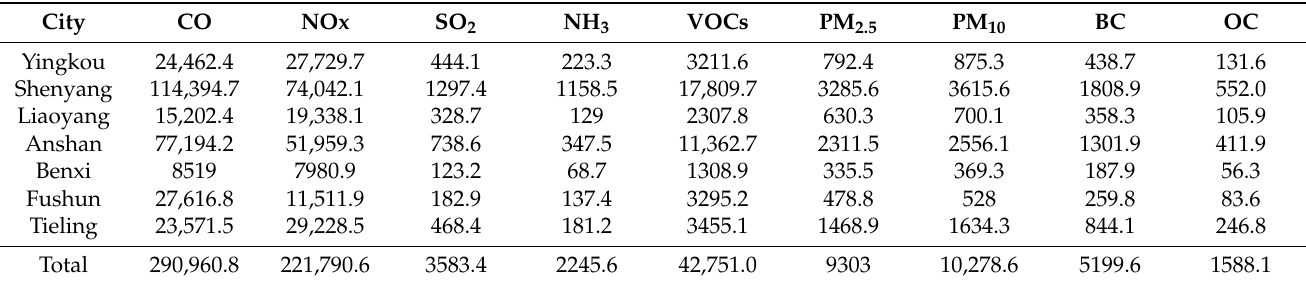
Table 3. Vehicle emissions in each city in the CLUA region in 2018